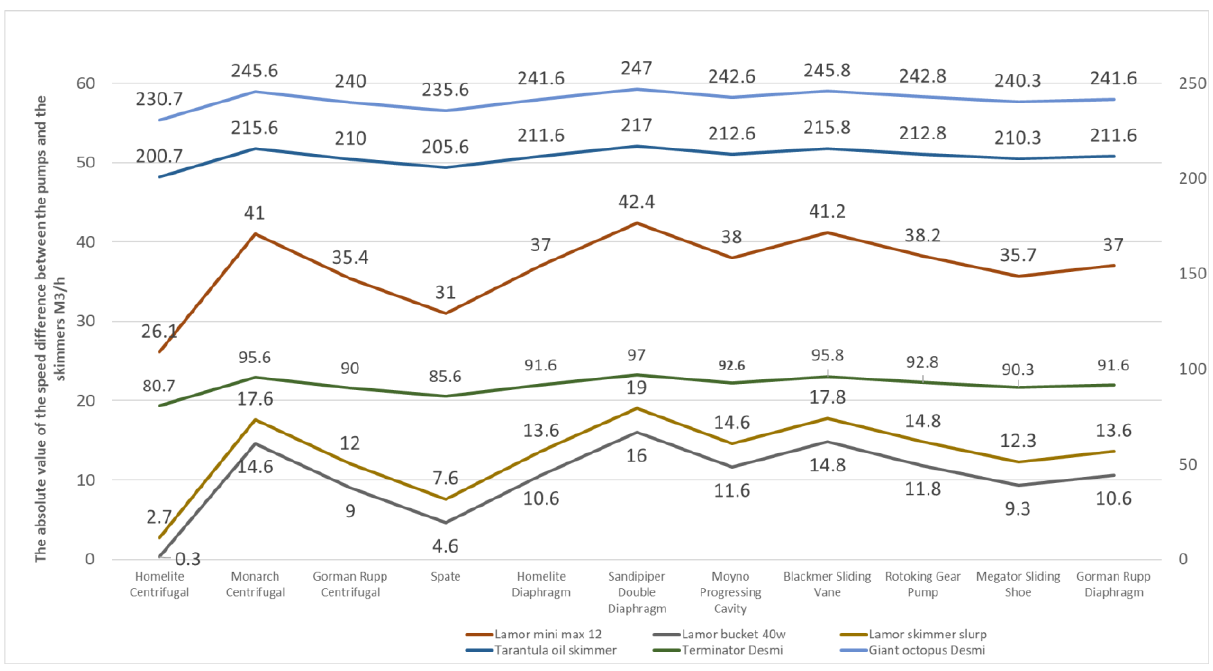
Figure 10 . The speed difference of oil collection between the pumps and the skimmers: Vicoma MIDI, Vicoma Mini Pover Vac, and Desmi DBD13-4.